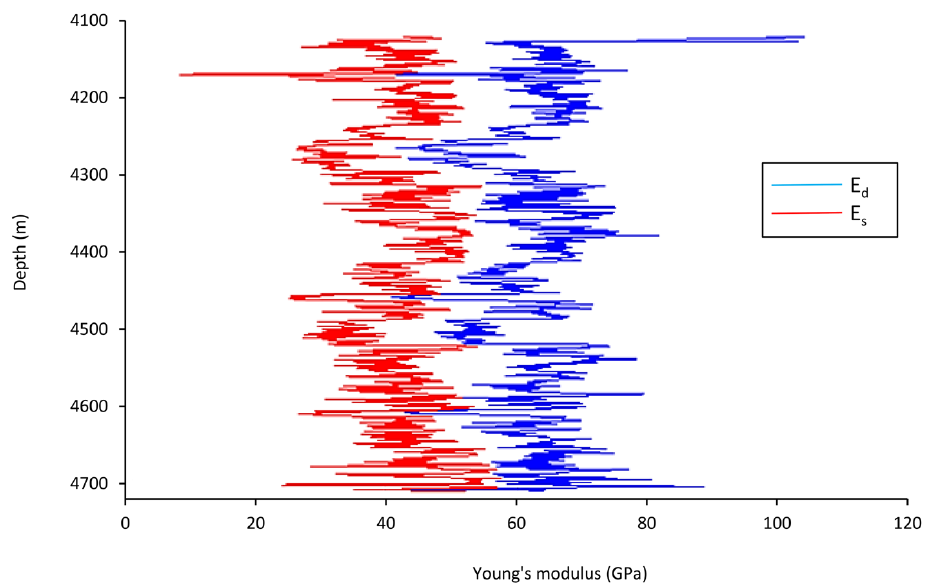
Figure 5. Changes in static ( E s ) and dynamic ( E d ) Young’s modulus vs. the depth of wellbore-D in the Azar oilfield.